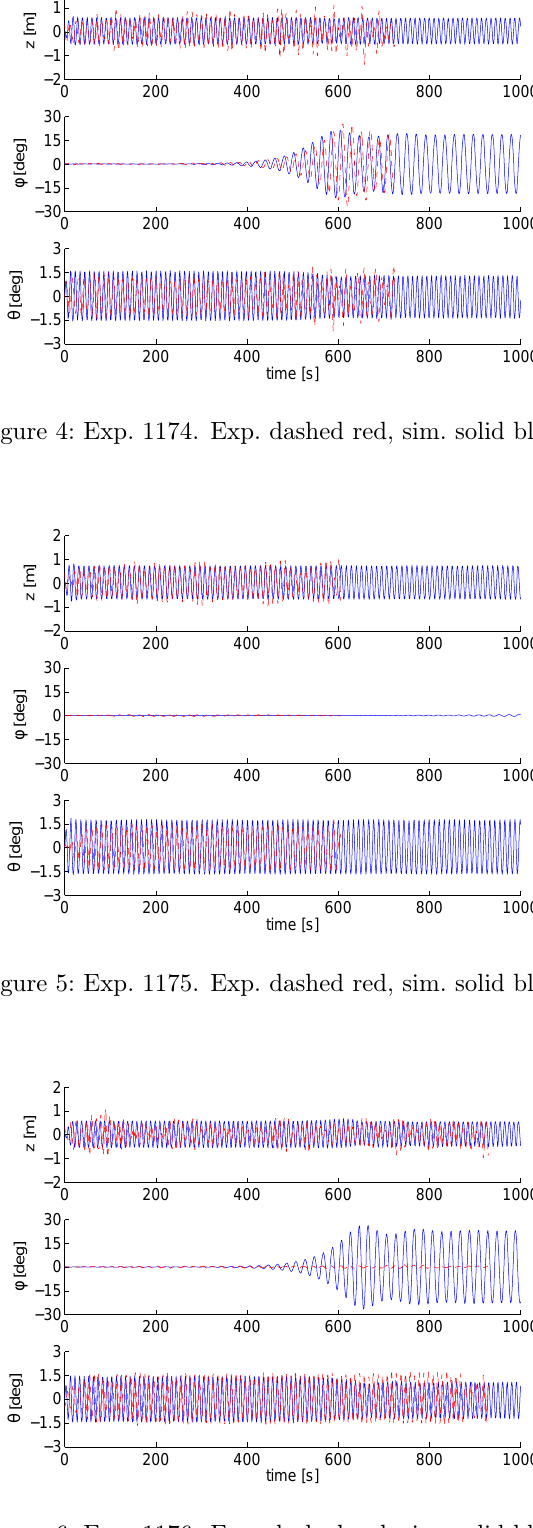
Figure 6: Exp. 1176. Exp. dashed red, sim. solid